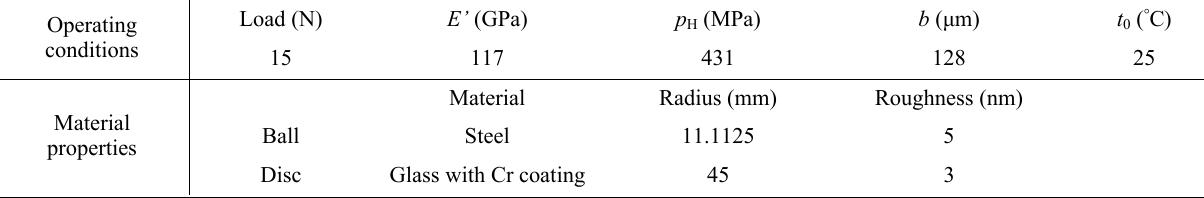
Table 1 Operating conditions for